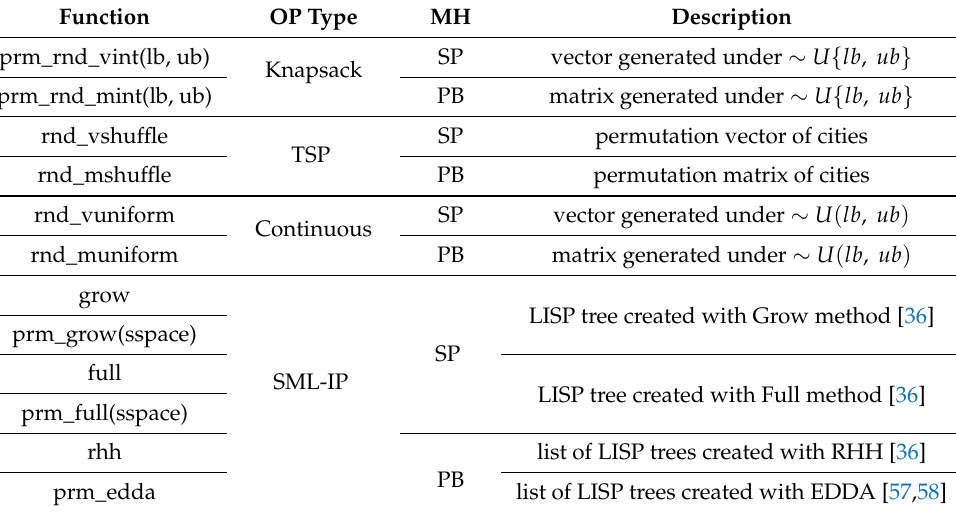
Table 1. Descriptions of the initializers